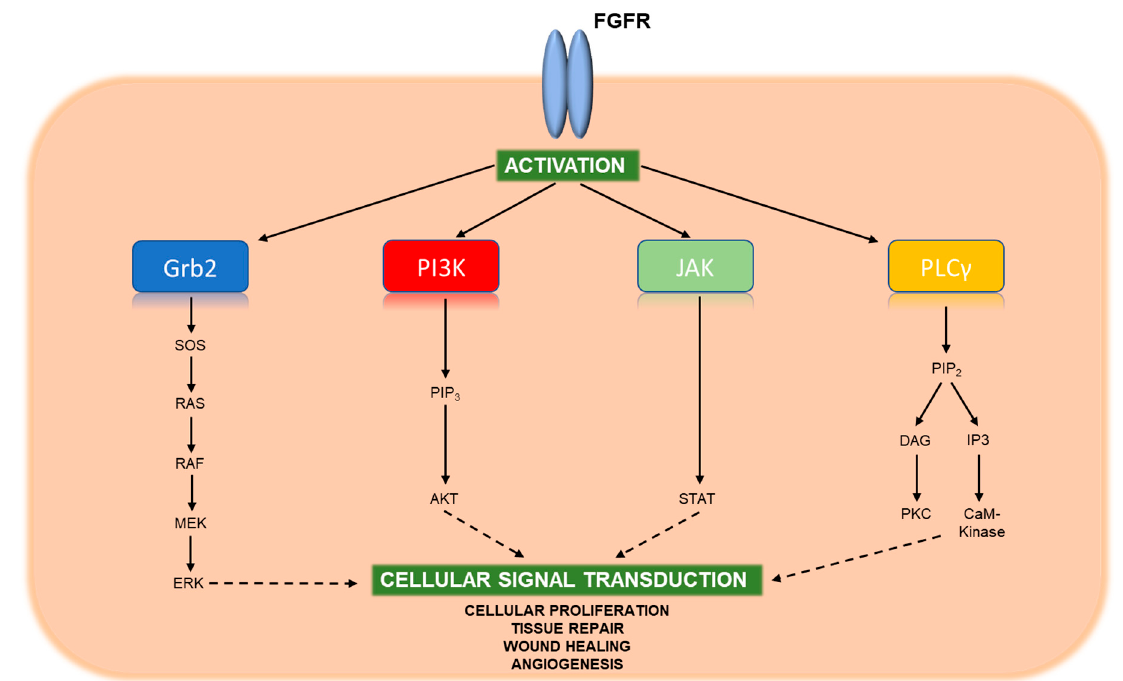
Figure 1. Key signaling pathways of activated FGFR. Upon binding FGF ligands, FGFR molecules dimerize and undergo cross-phosphorylation of tyrosine residues within their activation loops located near the cytoplasmic tail. This phosphor- ylation activates the kinase domain, which in turn binds and phosphorylates adaptor proteins of downstream signaling pathways. Four particularly important pathways include RAS-MAPK, PI3K-AKT, JAK-STAT, and PLC γ , which contribute to cellular proliferation, tissue repair, wound healing, and angiogenesis.